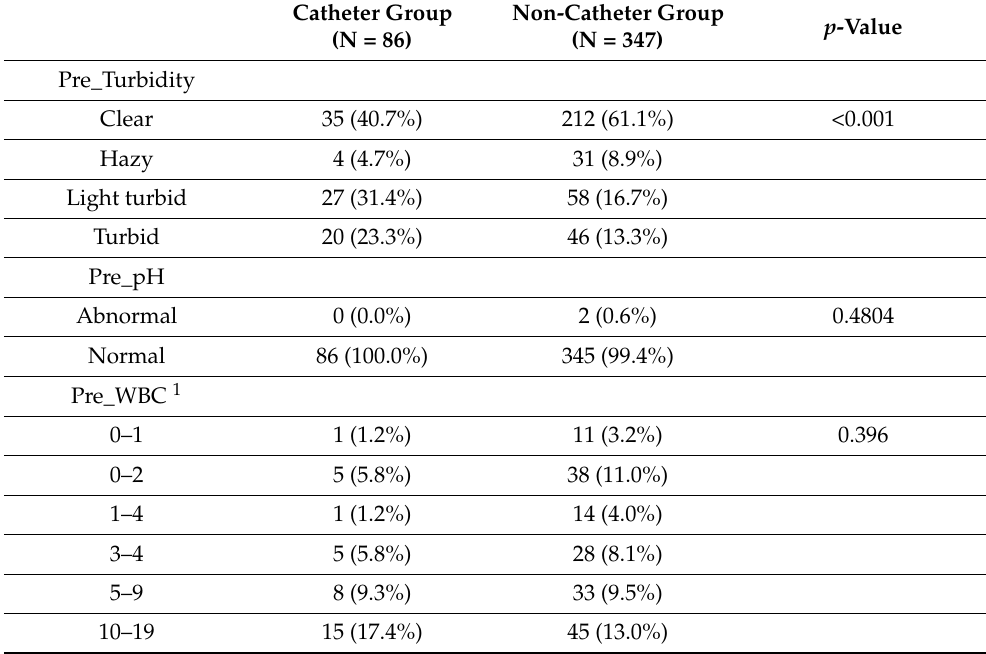
Table 2. The results of the urine tests before